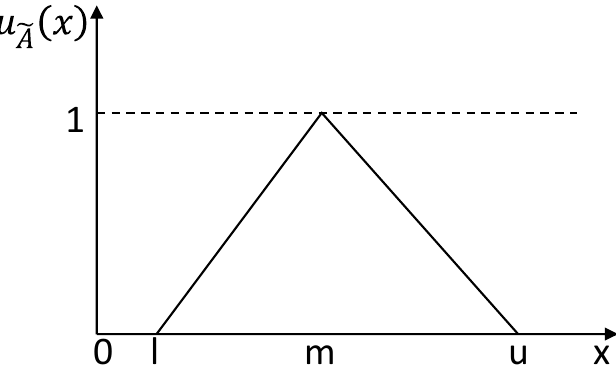
Figure 1. The membership function of TFN.